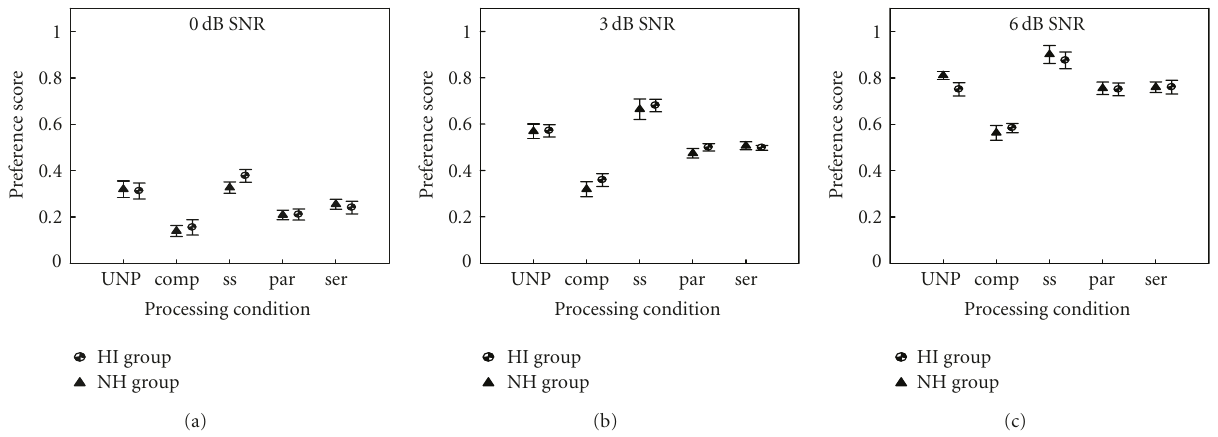
Figure 9: Subject preference scores for sound quality judgments grouped by SNR for listeners with normal hearing (closed triangles) and listeners with hearing loss (open circles). Error bars show the standard error of the preference scores for each group and condition. Symbols and error bars are o ff set slightly for clarity. Conditions are UNP: unprocessed, comp: dynamic range compression, ss: spectral subtraction, par: parallel, and ser: